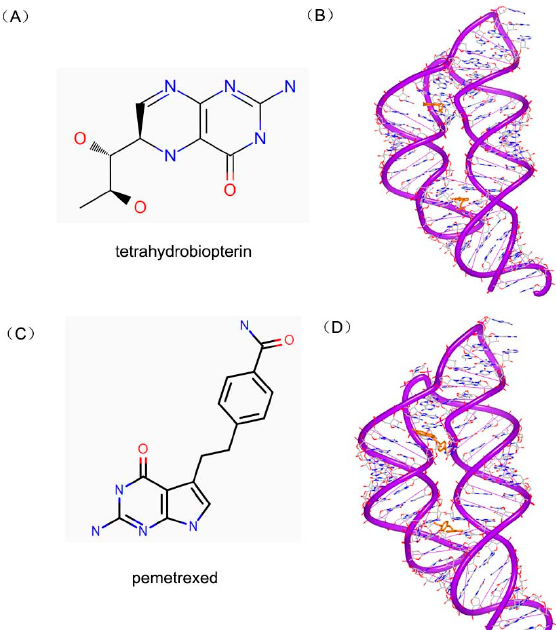
Figure 23. ( A ) Chemical structure of tetrahydrobiopterin; ( B ) complex of a RNA duplex with tetrahydrobiopterin (PDB code: 4LVX); ( C ) chemical structure of pemetrexe; and ( D ) complex of a RNA duplex with pemetrexed (PDB code: 4LVY). The orange structure represents the small molecule; the purple structure represents the backbone of nucleic acid; the blue and red atoms in the molecule represent nitrogen and oxygen atoms, respectively.